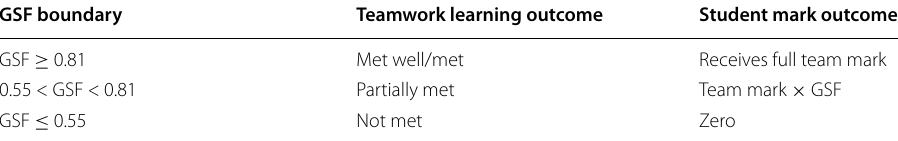
Table 2 The group skills factor (GSF) boundaries used to individualise a student’s mark